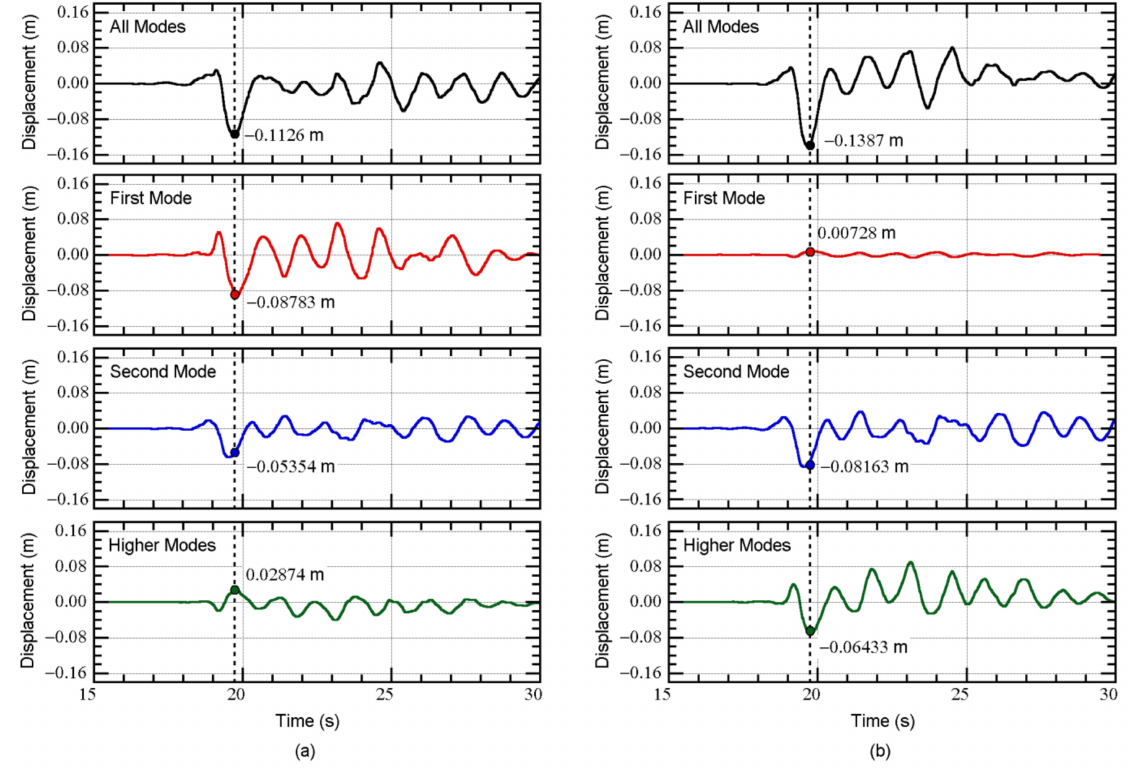
Figure 41. Comparisons of the modal responses at the edge of level 0 (structural model: Model-Tf34, ground motion: UTO0414, angle of incidence of seismic input: ψ = − 75 ◦ ): ( a ) X 1A and ( b ) X 6A